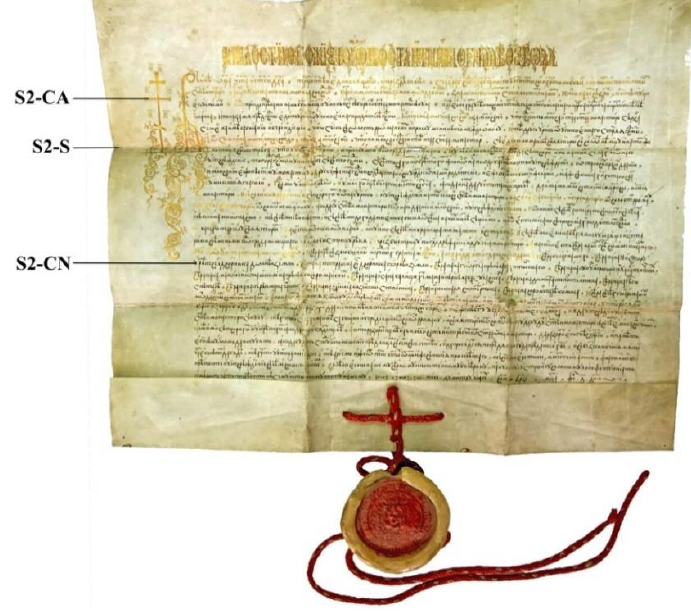
Figure 2. Parchment S2 with the index numbers of the analyzed areas.